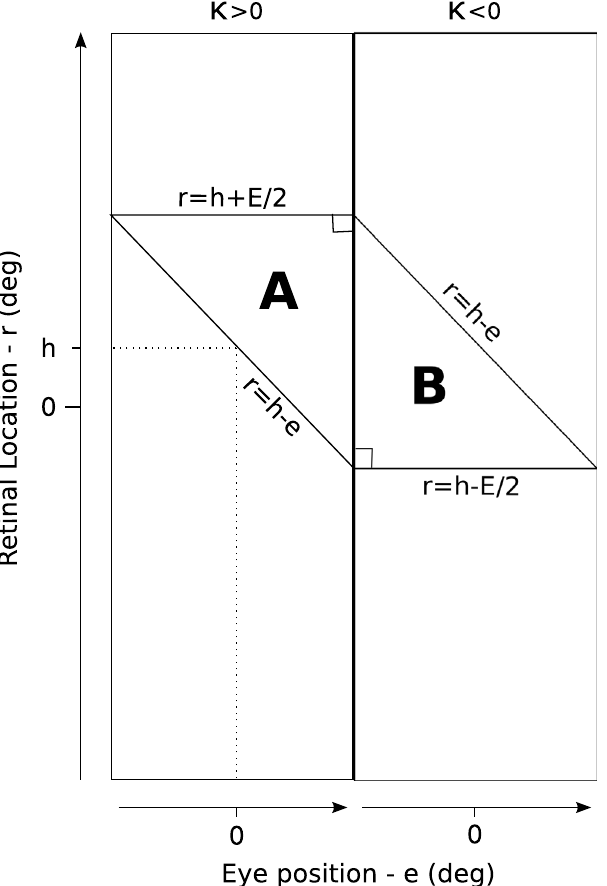
Fig 8. Synaptic weight structure of a network model that has been manually prewired in order to produce head- centred output neurons with input neurons that are modulated by a sigmoidal function of eye-position. The figure shows the structure of the canonical weight vector resulting from the prewiring Eqs 14 and 15. Each of the two rectangles represents the topographic organisation of one half of the input population in terms of retinal-preference ( α ) and eye-position preference ( β ), with the input neurons in the left rectangle having κ > 0 (positive gain) and the i j right rectangle having κ < 0 (negative gain). A neuron in the competitive output population which has been assigned a head-centred receptive field at location h will have elevated connections from input neurons with preferences located in the right-angled triangles of the input space, labeled A and B .